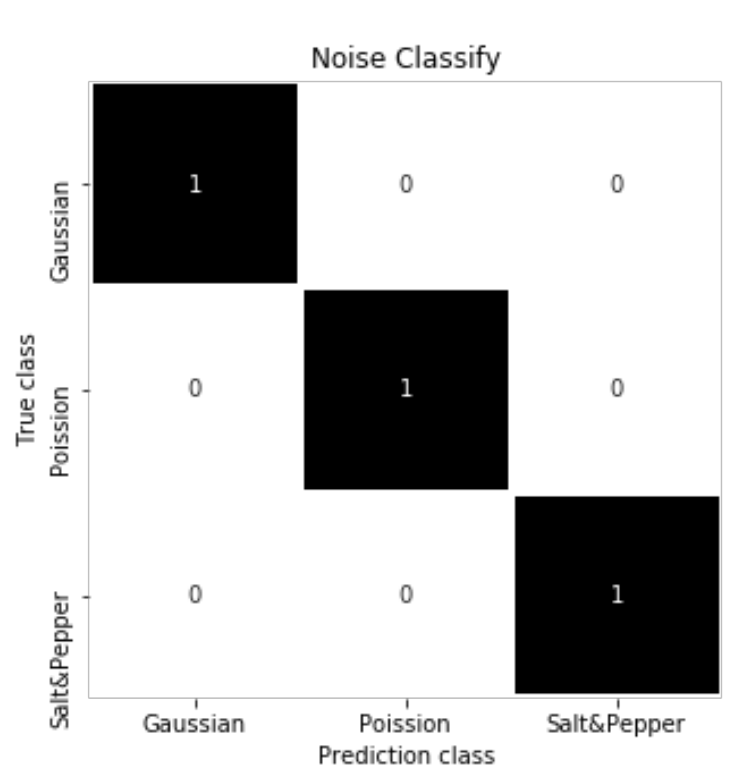
Figure 11. Confusion matrix for test data